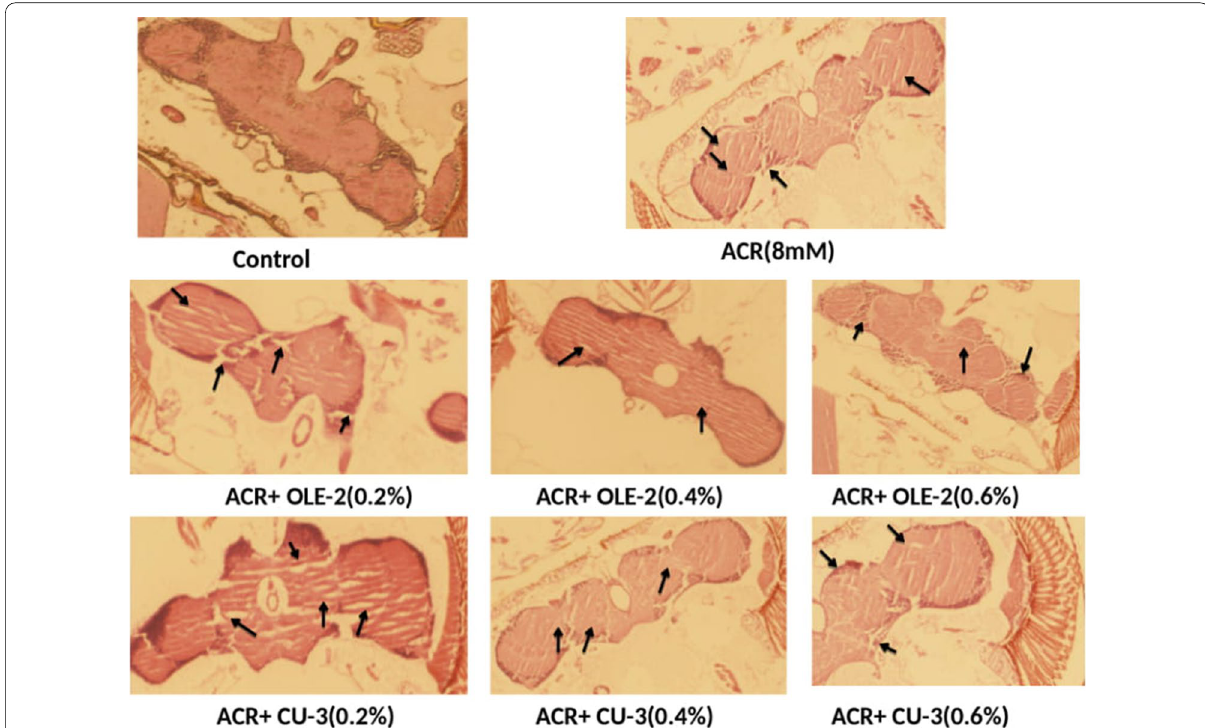
Fig. 10 The control fly’s brain showed no vacuolated areas and no tissue gaps in central body complex but ACR treated fly brain showed more tissue gap in central and optical lobe, more over ACR plant fraction (OLE-2 and CU-3) treated group showed less vacuolated areas and tissue gap + compared to ACR treated